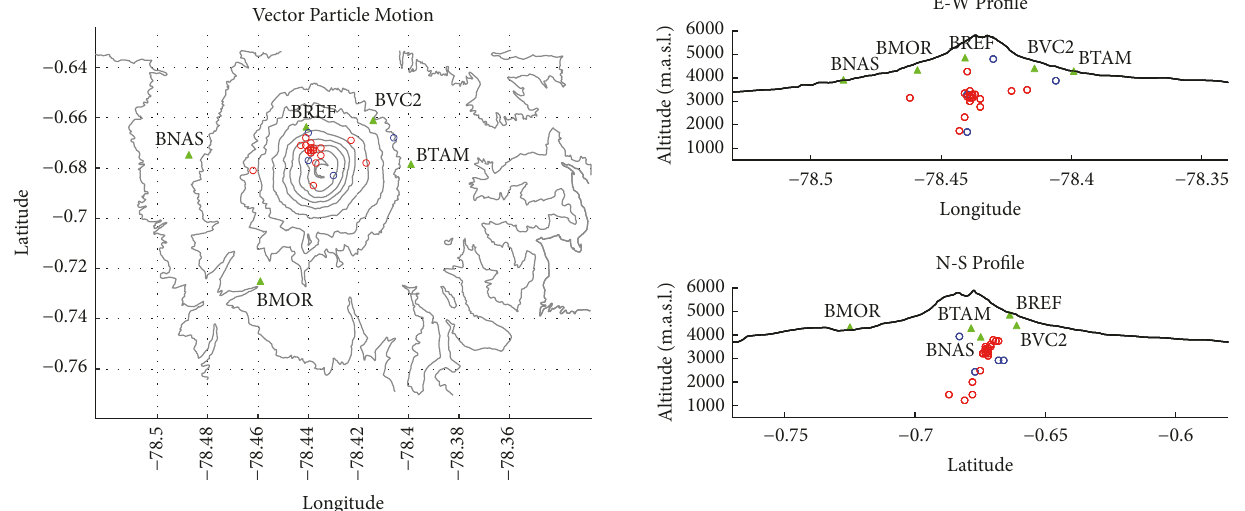
Figure 6: Source locations are obtained via particle motion. Red dots indicate locations for events before the eruption while blue dots are for events after the eruption. Stations are marked with green